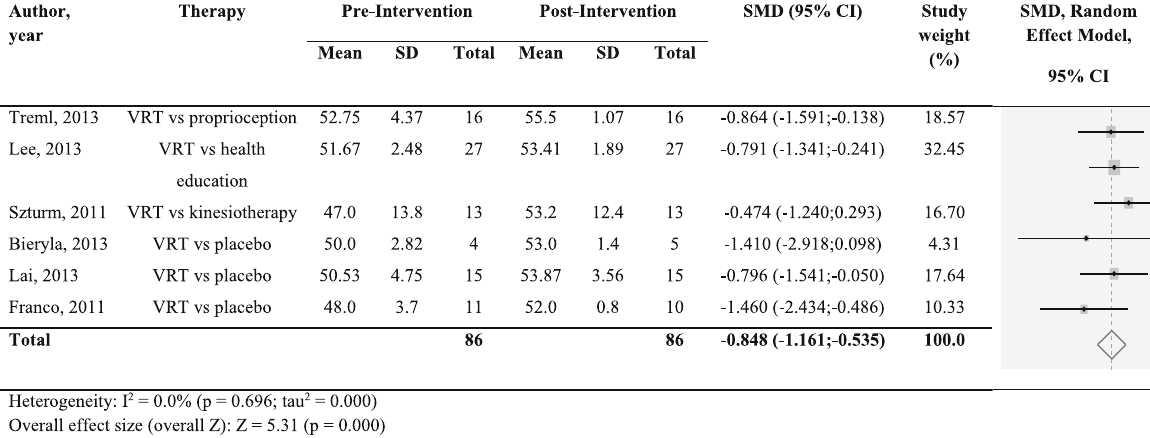
data from six studies ( N = 174)